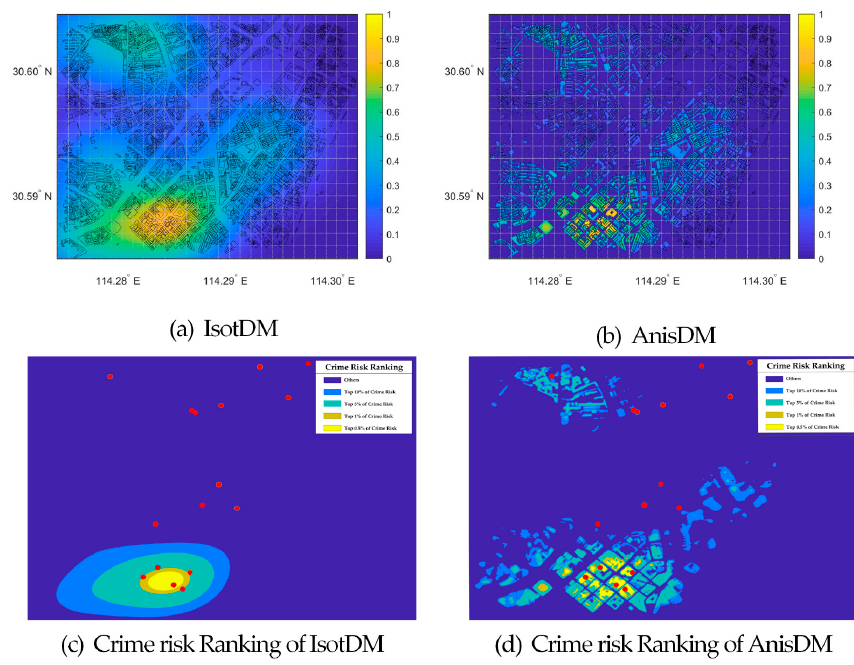
Figure 10. Prediction accuracy of IsotDM and AnisDM.